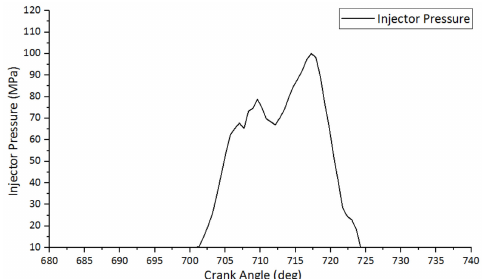
Figure 6. Curve of fuel injection pressure.